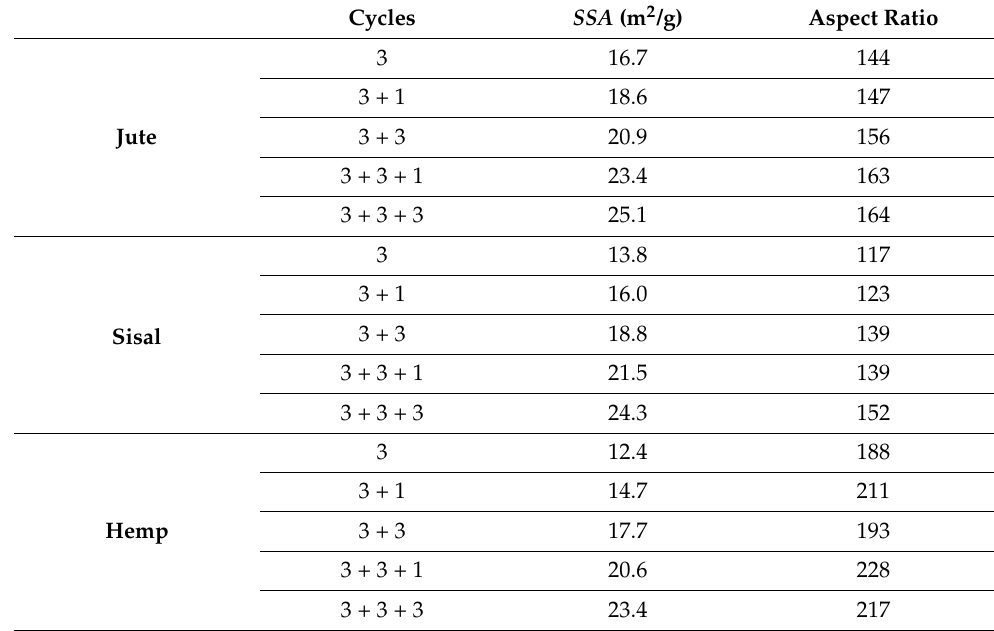
Table 2. Influence of the number of HPH cycles on the specific surface area and the aspect ratio of MNFCs that have undergone a mechanical